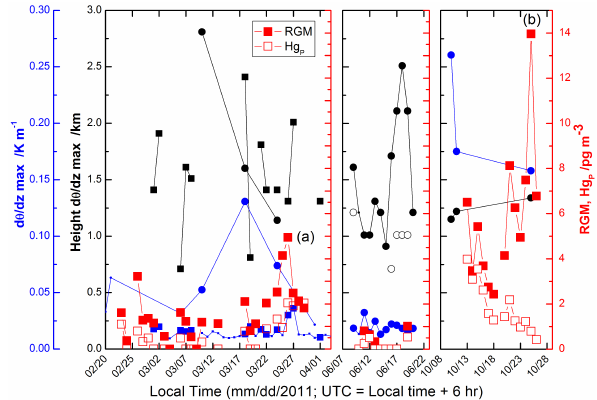
Fig. 7. Maximum lapse rate (blue) and height of maximum and sec- ond maximum lapse rates (solid and empty black circles respec- tively) obtained from radiosonde data during the CHARLEX cam- paign. The small blue circles (note corresponding missing black cir- cles) indicate an uncapped boundary layer. In red: reactive gaseous mercury (RGM; full symbols) and particulate mercury (Hg P ; empty symbols). The peak in RGM and Hg P at the end of March (a) is likely related to the disappearance of the inversion and the subse- quent subsidence of free tropospheric air masses. The peak in RGM at the end of October was (b) most likely due to a localized and short-lived